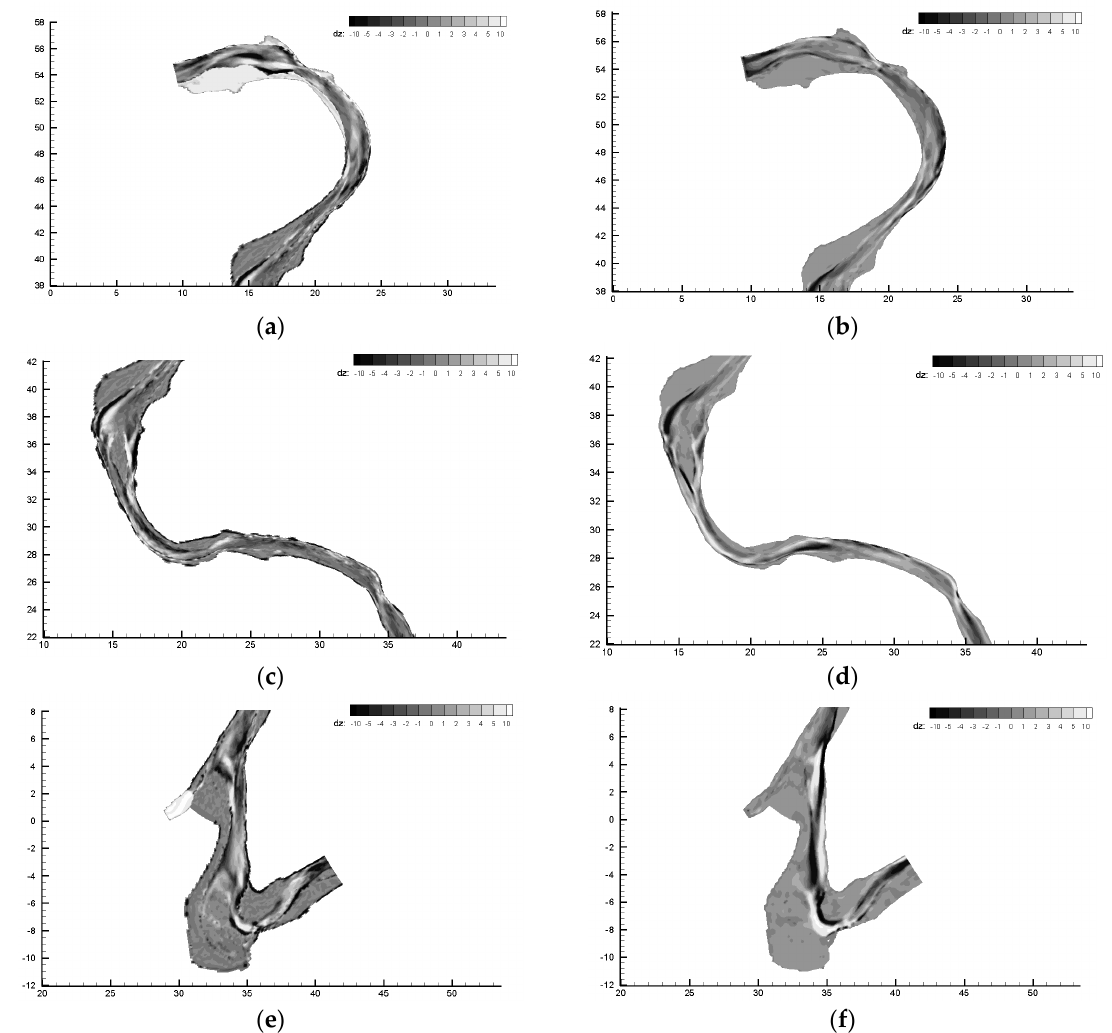
Figure 4. Calculated and measured scour or deposition depths of reach section (x: the distance from the x-direction / m; y: the distance from the y-direction / m; dz: the bed level changes / m). ( a ) Measured; ( b ) calculated; ( c ) measured; ( d ) calculated; ( e ) measured and ( f ) calculated.